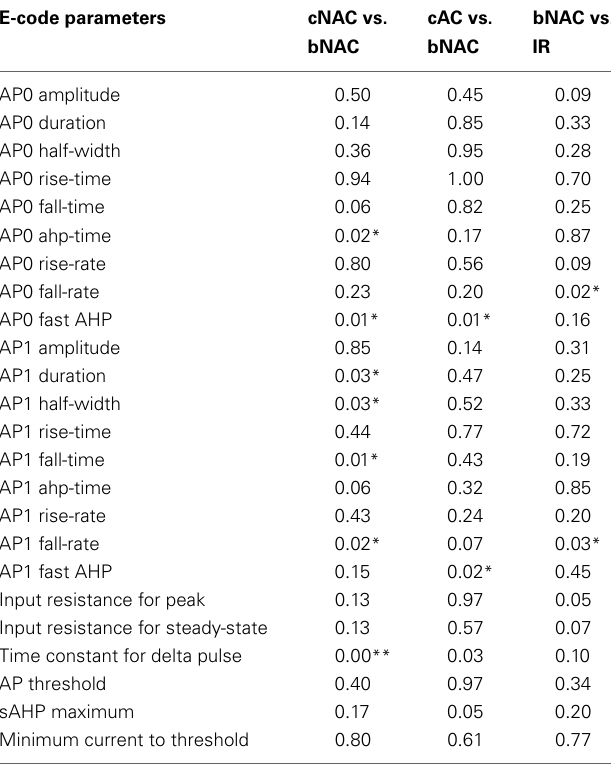
Table 4 | Table of the p -values (Students’ t -test) of comparisons between electrophysiological groups in Table